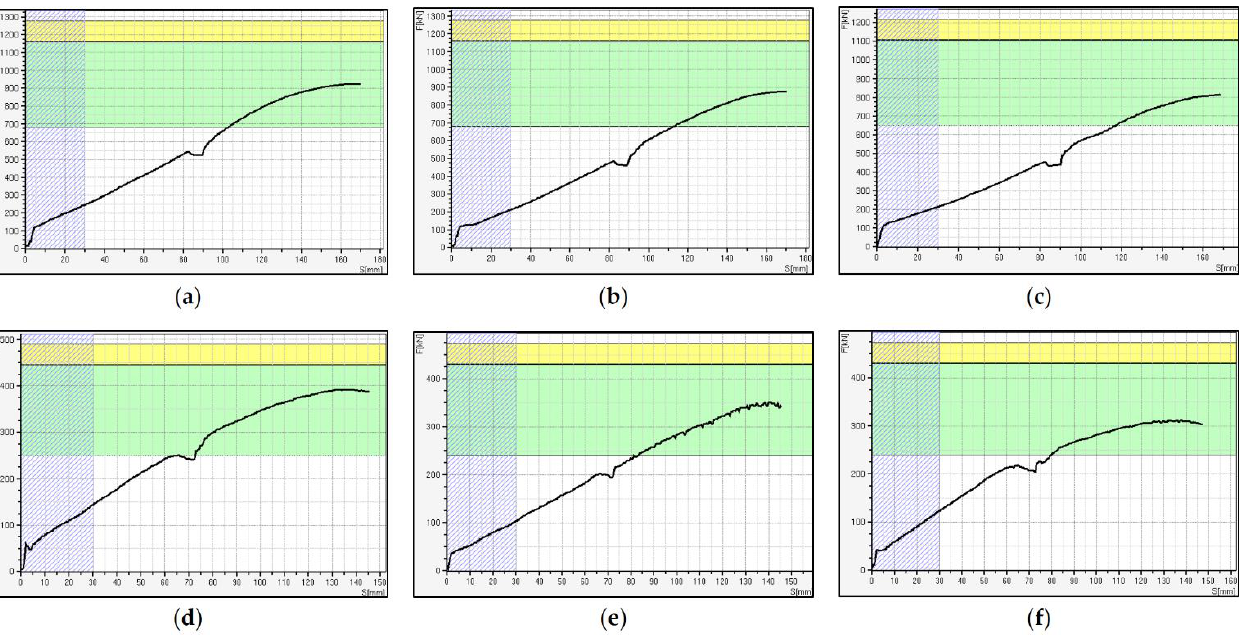
Figure 1. Some examples of force-displacement (press-fit) curves. Figures ( a – c ) are the qualified images of press-fit curves, and Figures ( d – f ) are the unqualified examples. In the figures, the y -axis is the press-mounting force, and the x -axis is its corresponding displacement.